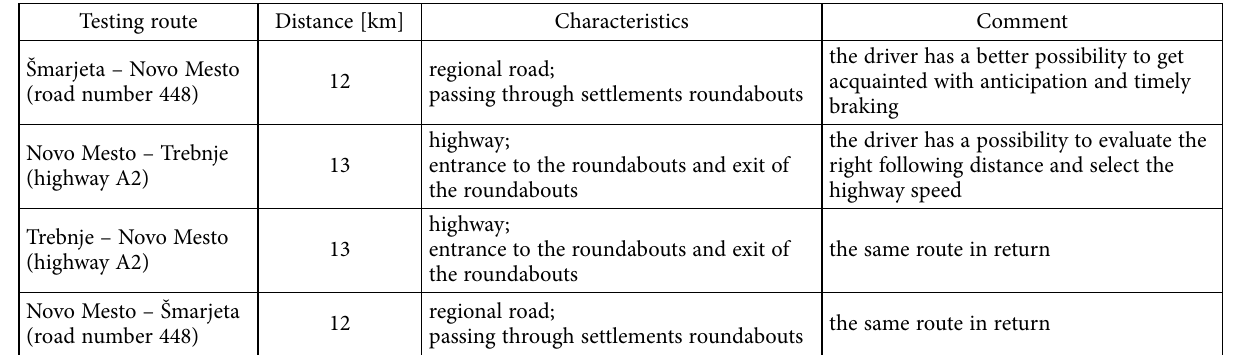
Table 1. Testing